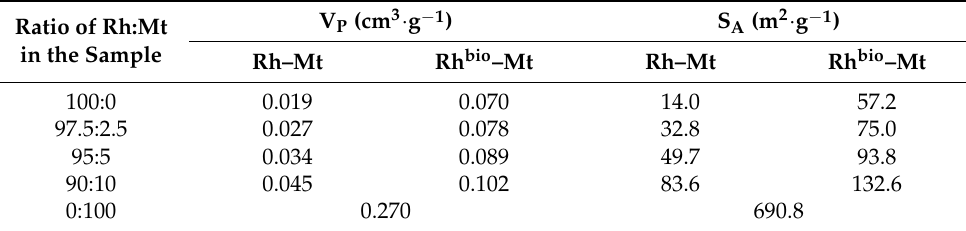
Table 2. Characteristics of the pore structure of hybrid phytocomposites and their components. Ratio of Rh:Mt in